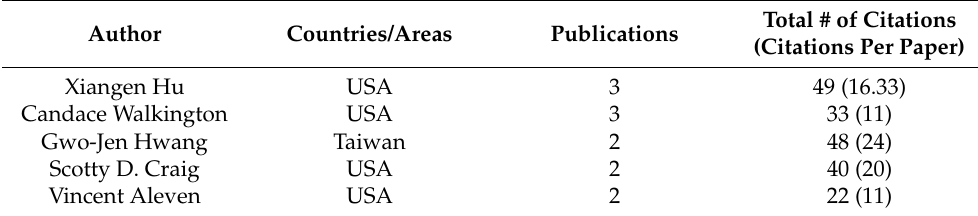
Table 2. Top authors ranked by number of